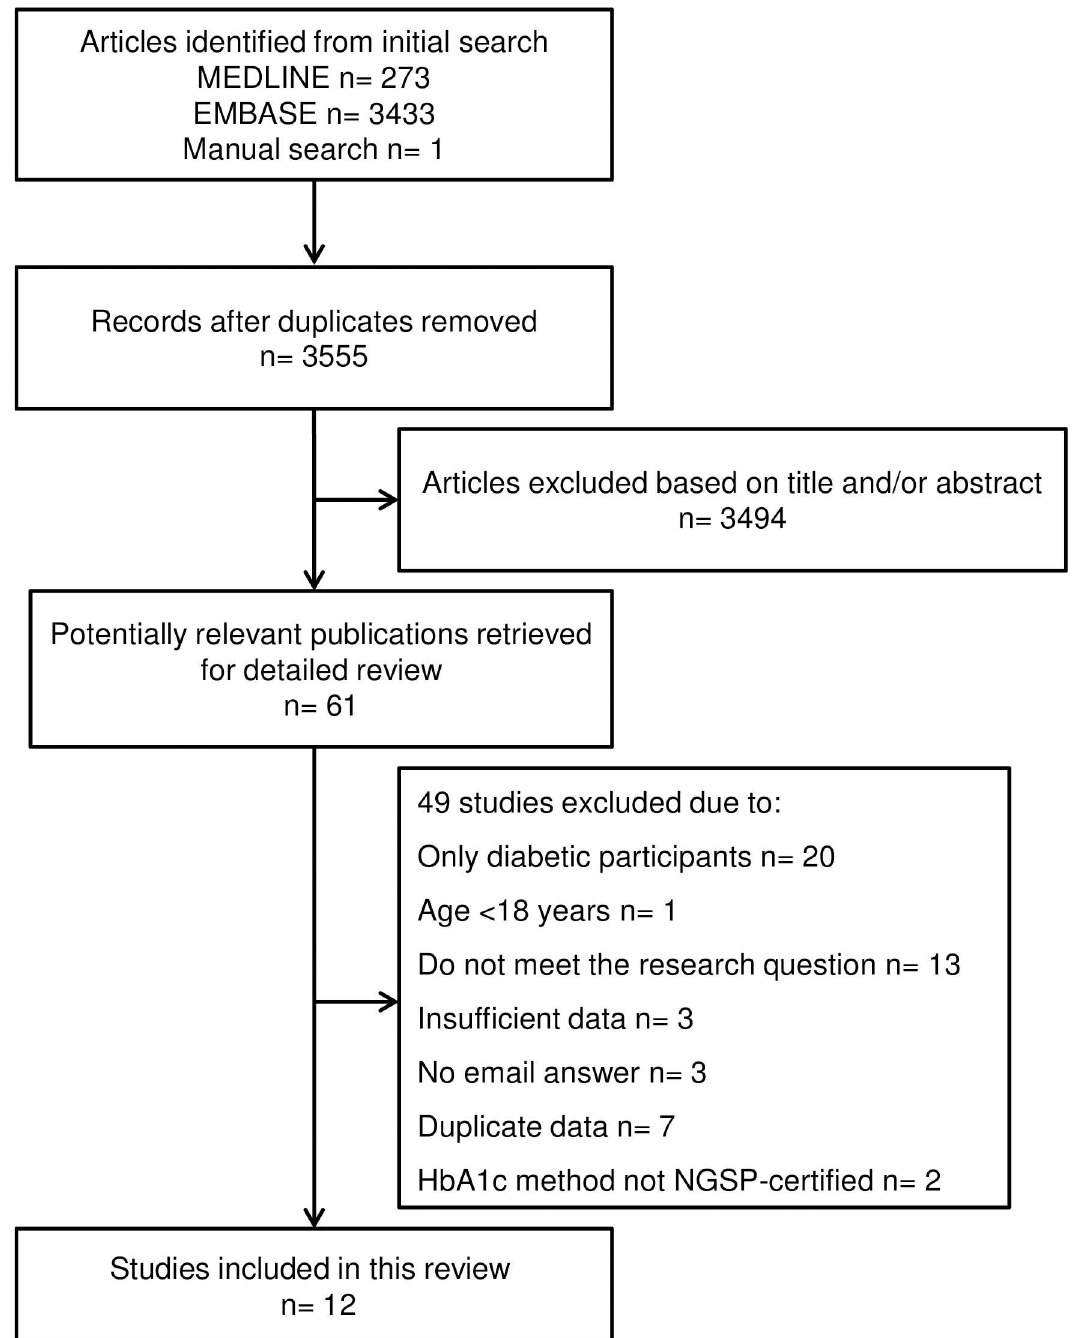
Fig 1. Flowchart of the article selection